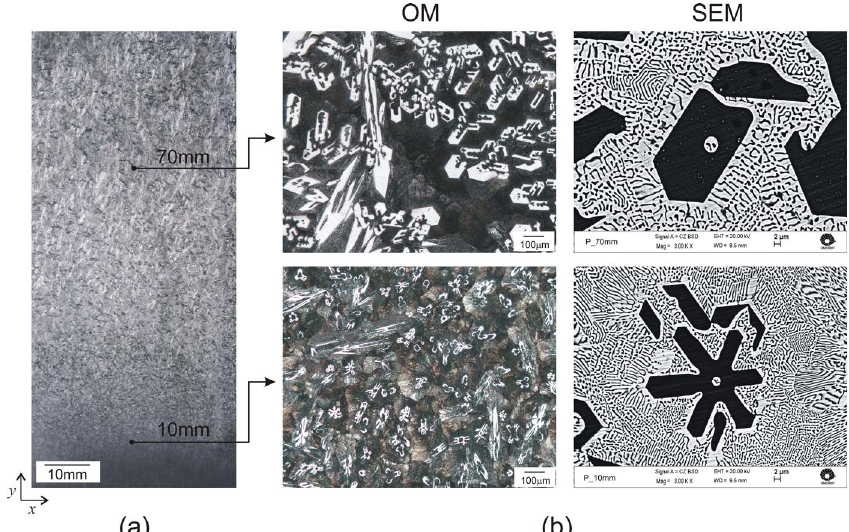
Figure 3. (a) Macrostructure and (b) Microstructure in optical microscope (OM) and scanning electron microscope (SEM) for positions: P_10mm and P_70mm, in which P is the distance from the cooling